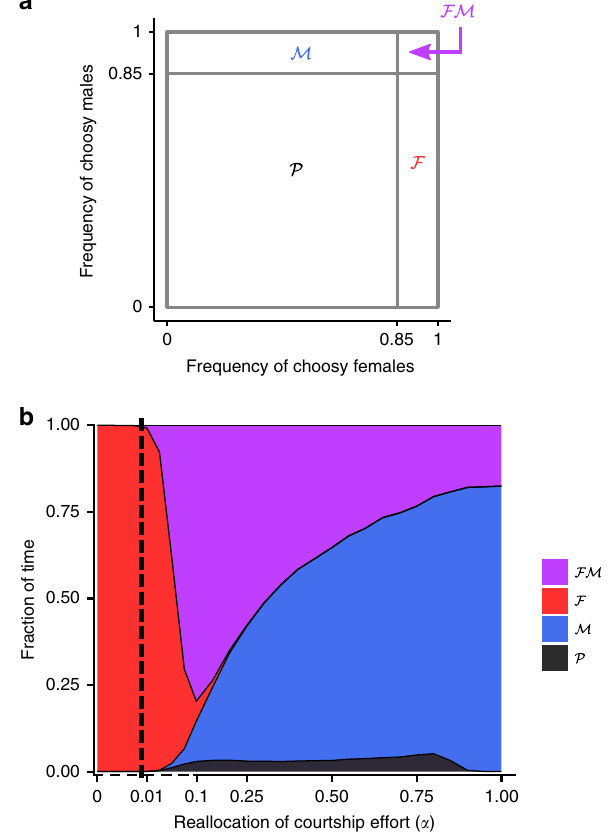
Fig. 3 Time spent in each regime of choosiness in stochastic simulations. a Four regimes of choosiness are de fi ned to describe stochastic simulations: mutual mate choice ( FM ), male mate choice ( M ), female mate choice ( F ), and partial mate choice (i.e., both female and male choosiness occur at intermediate or low frequencies < 0 : 85, P ). b Fractions of time spent in each regime as a function of the reallocation of courtship effort ( α ), in stochastic simulations with s ¼ 0 : 2 and K ¼ 500 measured after the equilibrium predicted by the deterministic model has been reached for the fi rst time. The vertical dashed line corresponds to the threshold above which the deterministic equilibrium is mutual mate choice ( α > 0 : 01, Fig. 2a). In stochastic simulations, in contrast, assortative mating is often based on male choosiness only (regime M ). Moreover, for partial reallocation of courtship effort ( α 2 ½ 0 : 01 ; 0 : 9 (cid:4) ), female and male populations are partly choosy (regime P ) for signi fi cant time periods